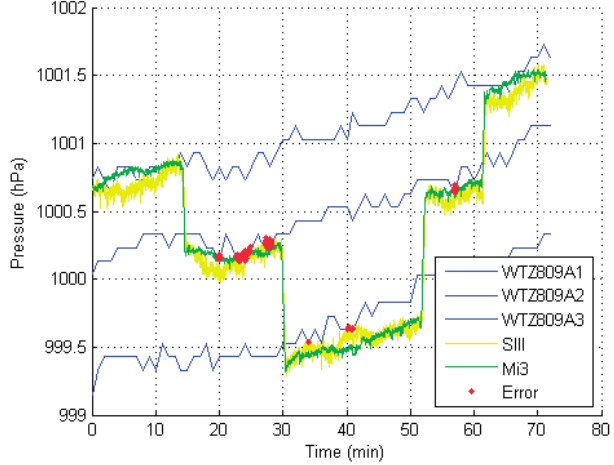
Figure 11. Experimental result in the underground shopping center (using a 1-s time